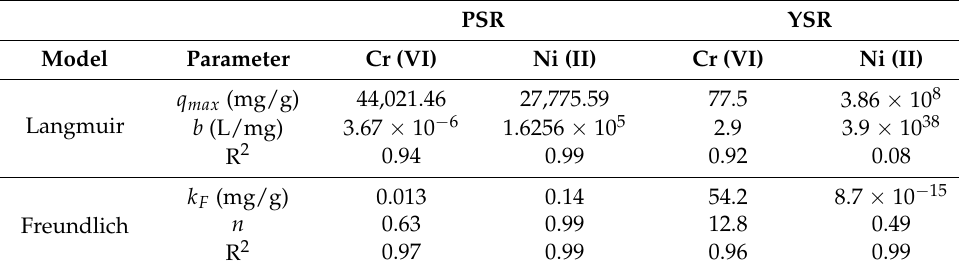
Table 9. Fitting parameters of isotherm